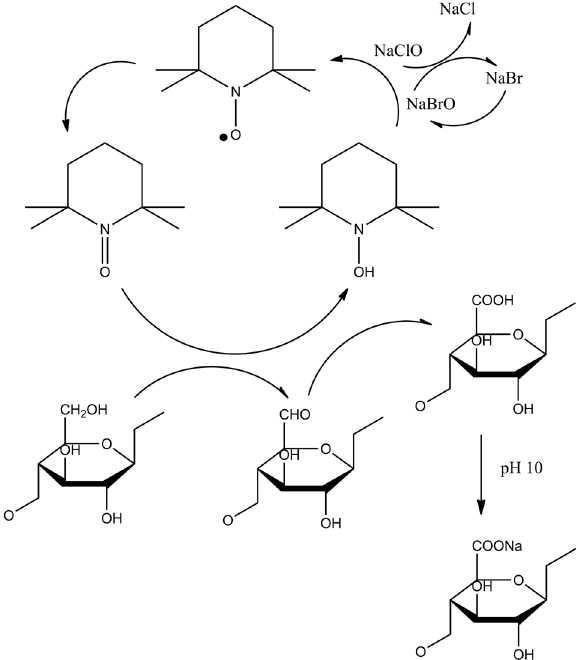
Figure 2: Pathway of oxidation process of C6 primary hydroxyl to carboxylate group [24].